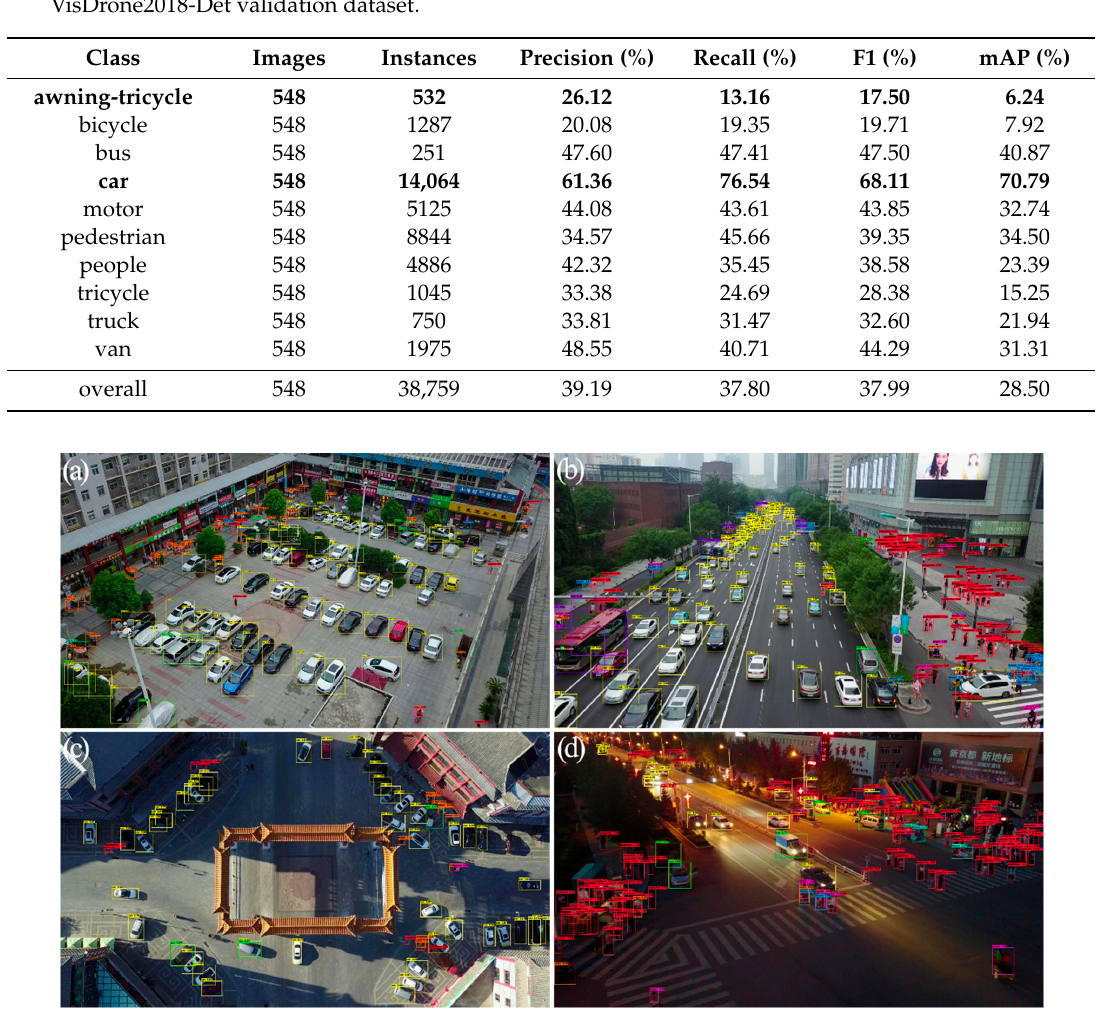
Figure 8. Partial test results obtained with Mixed YOLOv3-LITE using VisDrone2018-Det Val